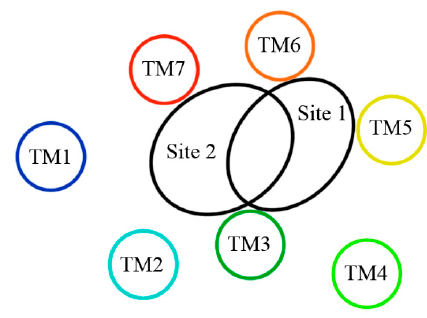
Figure 11. The sterically accessible binding pockets within the 5-HT 2A receptor regarded as Site 1 (agonist site) and Site 2 (antagonist site) [40,60].